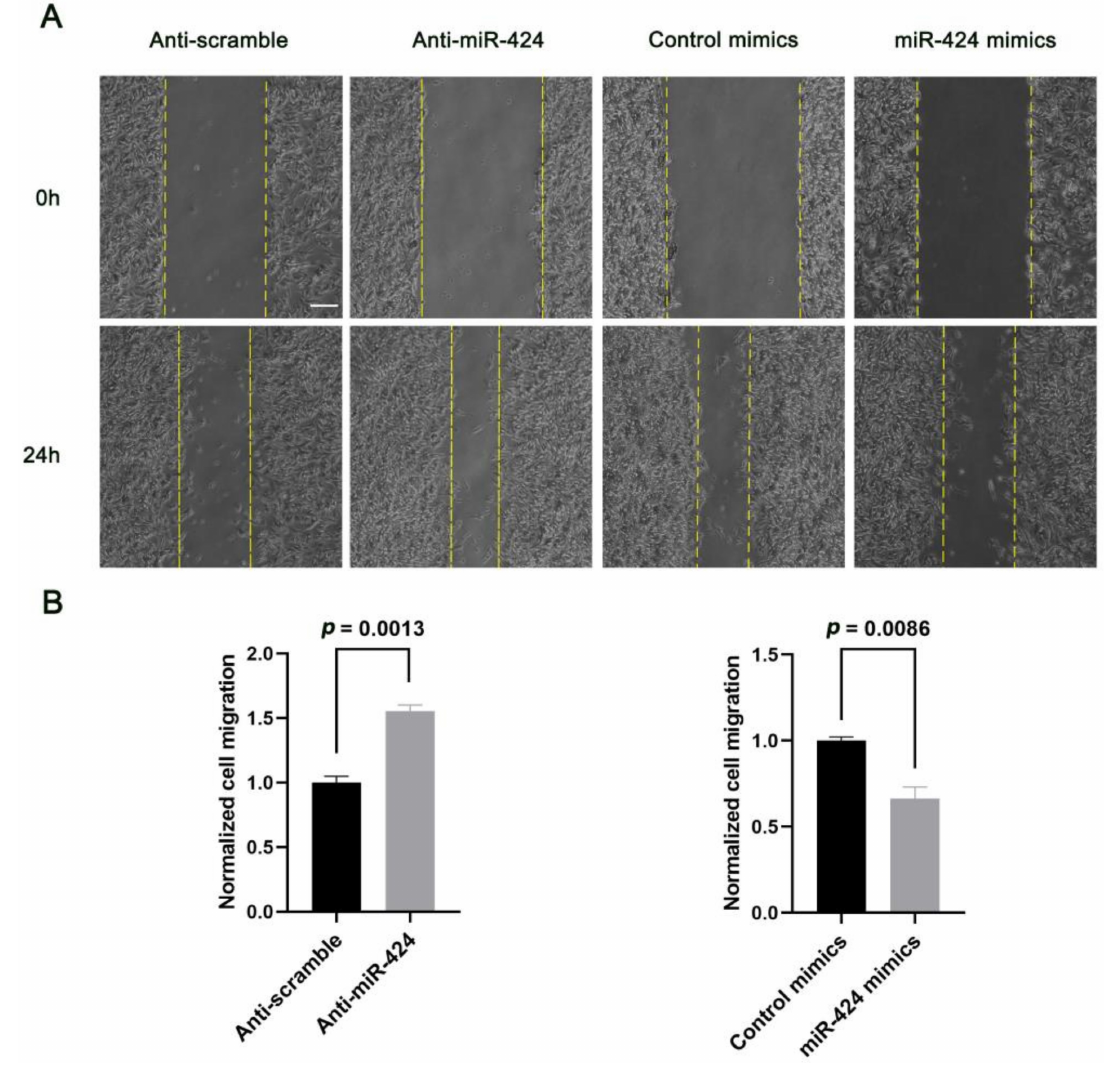
Figure 3. The effects of miR-424 on the migration of human neural cells. ( A ) Wound healing assay on SH-SY5Y cells: 72 h after transfection with control mimics, miR-424 mimics, anti-scramble, or anti-miR-424, the confluent transfected SH-SY5Y cells were scratch wounded. An additional 24 h was required for incubation, and images were taken at 0 h and 24 h. Scale bar = 200 µ m. ( B ) Quantification of cell migration of SH-SY5Y cells. Cell migration was normalized to anti-scramble- or control mimic- treated cells. Error bar = SEM (standard error of the mean); n =